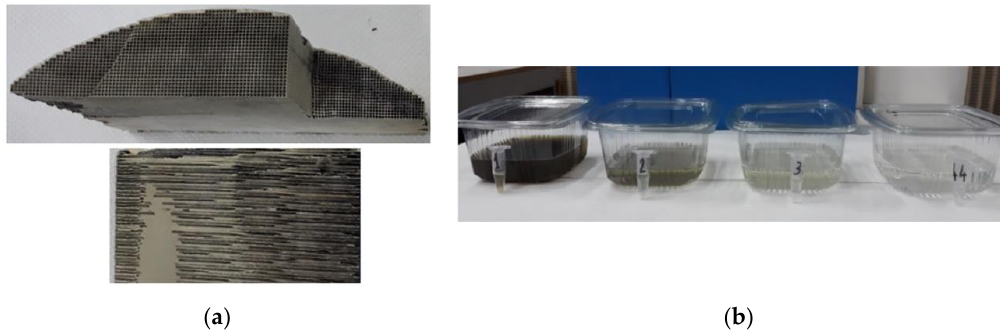
Figure 2. ( a ) Selective catalyst reduction catalyst fracture; ( b ) Liquid sample after four hydrodynamic cavitation stages. The initial cavitation contained 50 g of the catalyst and resulted in a dark liquid (1); the sediment from the first cavitation was subjected to another cavitation and resulted in a dark grey liquid (2); the sediment from the second cavitation was subjected to another cavitation and resulted in a light grey liquid (3); the last cavitation contained only the sediment from the third cavitation and resulted in a transparent liquid.